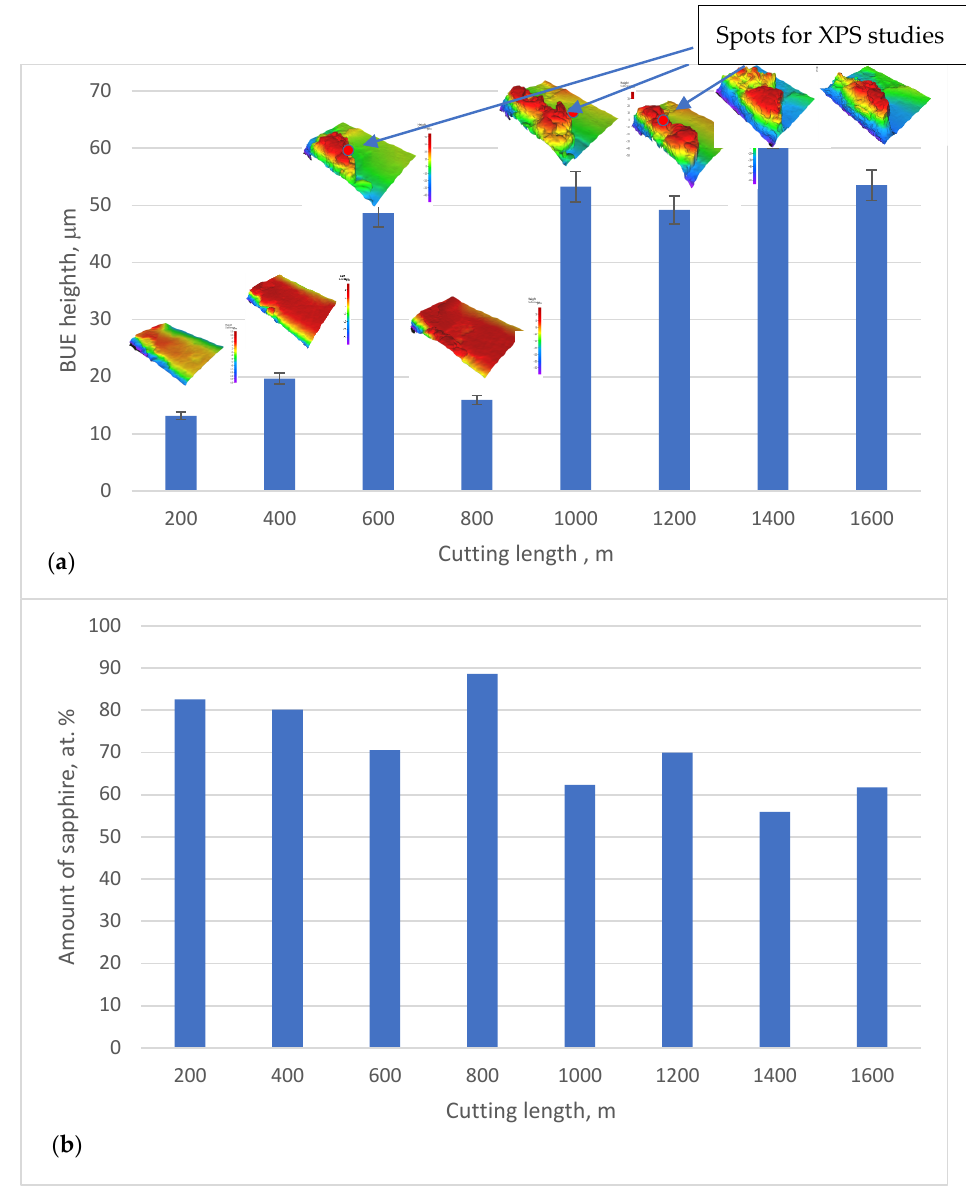
Figure 3. The progression of buildup edge (BUE) vs. length of cut on the tool in relation to sapphire tribo-film formation on the surface of the CVD-coated tool during the machining of an austenitic AISI 304 stainless steel: ( a ) numerical data showing BUE heights with length of cut; ( b ) quantity of tribo-films formed on the friction surface vs. length of cut (XPS data).